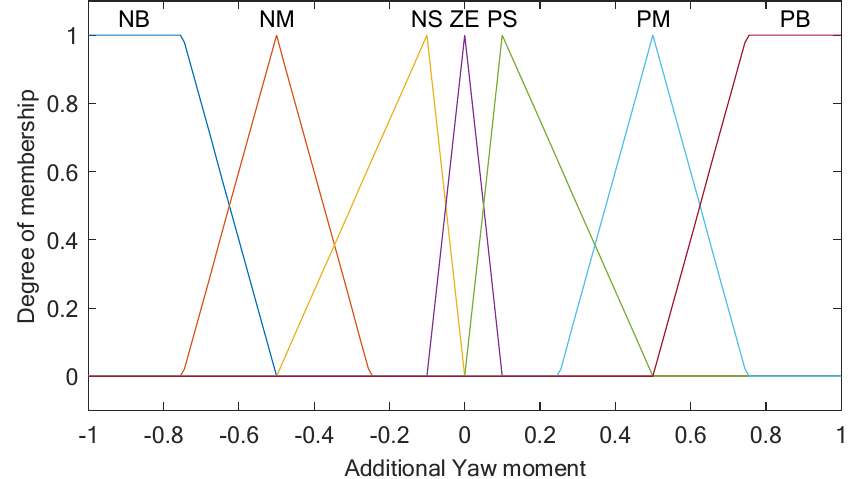
Figure 7. Membership function of the side slip angle deviation.